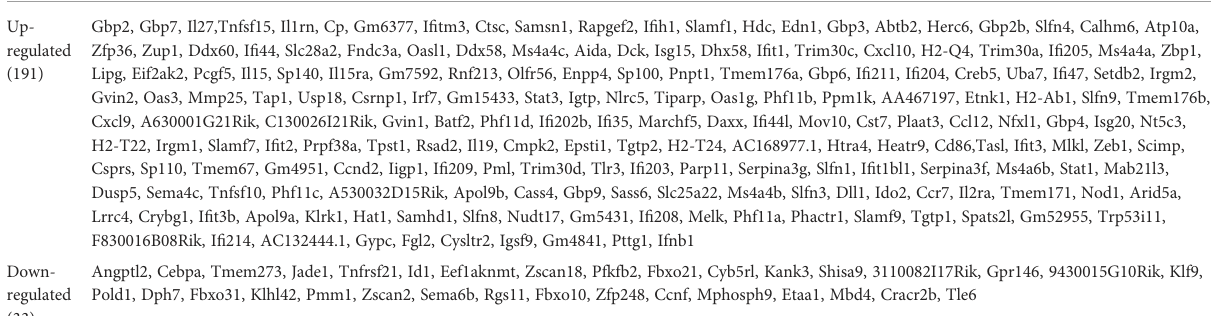
TABLE 2 Details of DEGs showing up or down regulation. DEGs Genes symbol